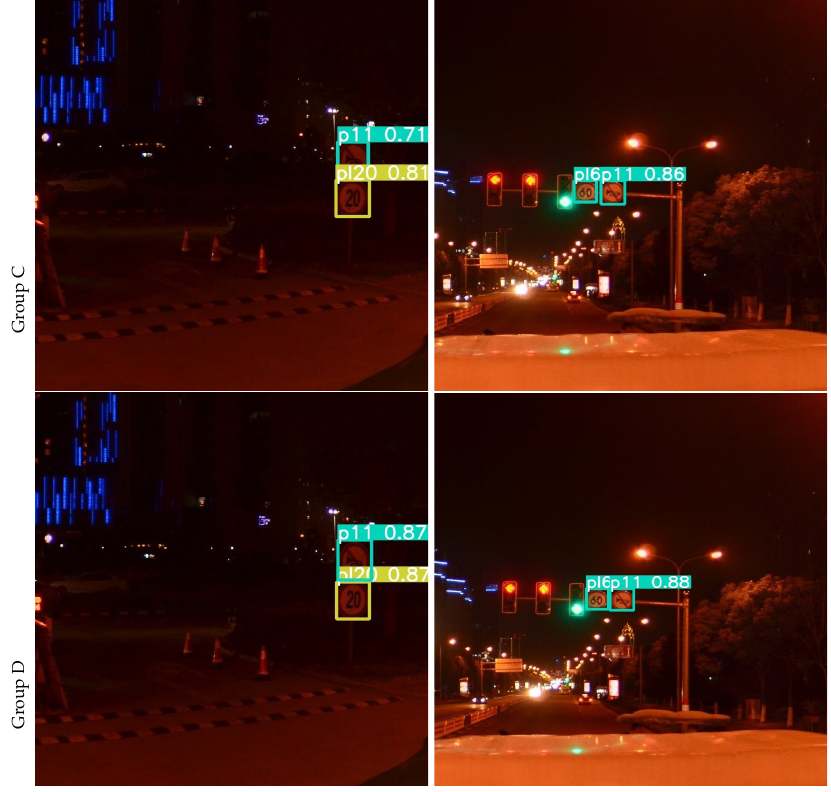
Figure 9. Detection in night